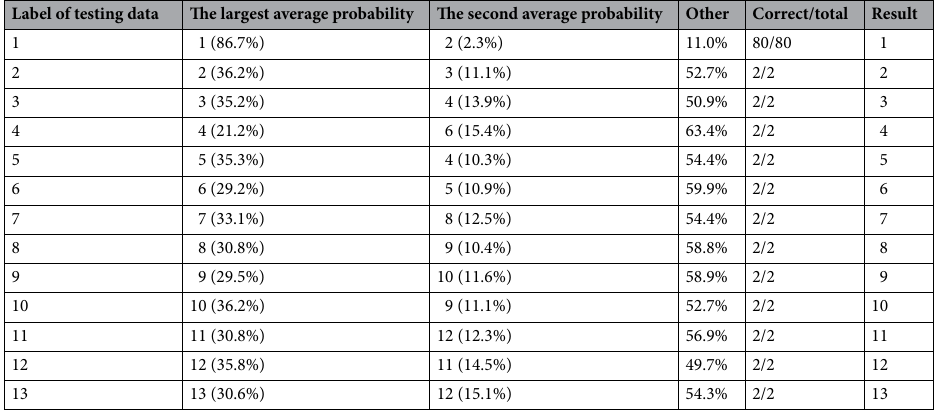
Table 6. PZT self-fault